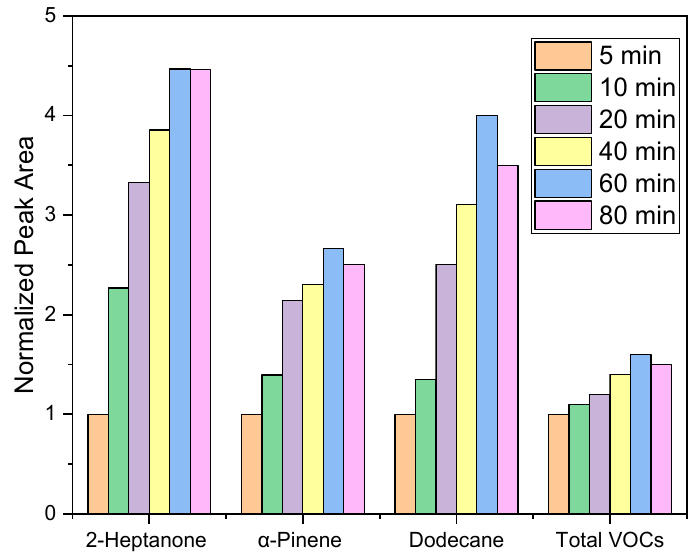
Figure 3. Evaluation of the extraction time for SPME Arrow.